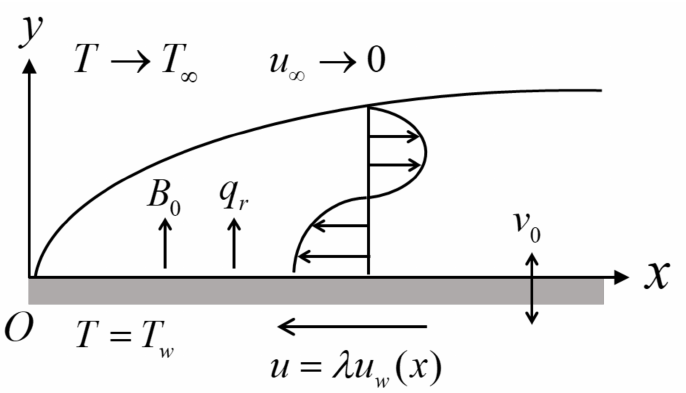
Figure 1. The flow